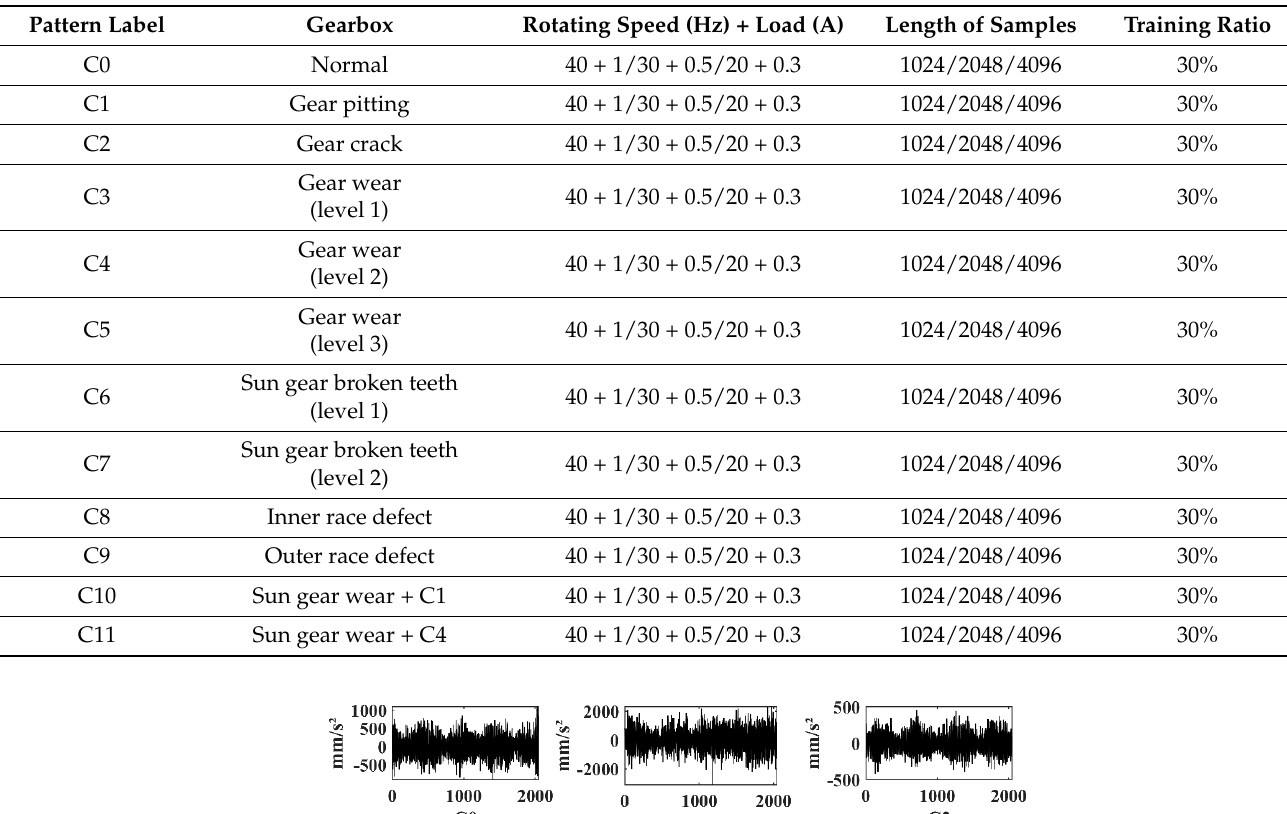
Table 2. Details about the dataset.